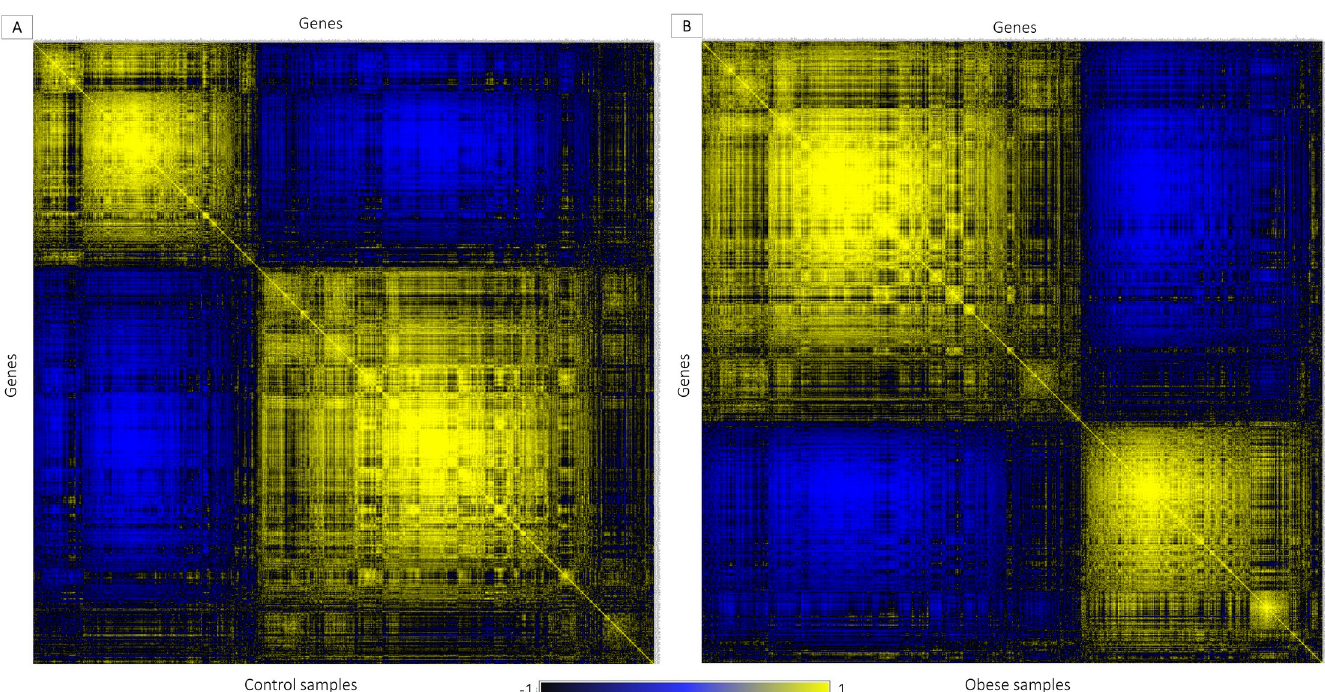
Fig 3. Representation of gene-gene correlation plot. The correlation plots illustrate substantial variations in gene expression among the gene pairs in the control (lean) and obese samples. A). Gene-gene correlation of lean samples (control), B). Gene-gene correlation of obese samples (disease)